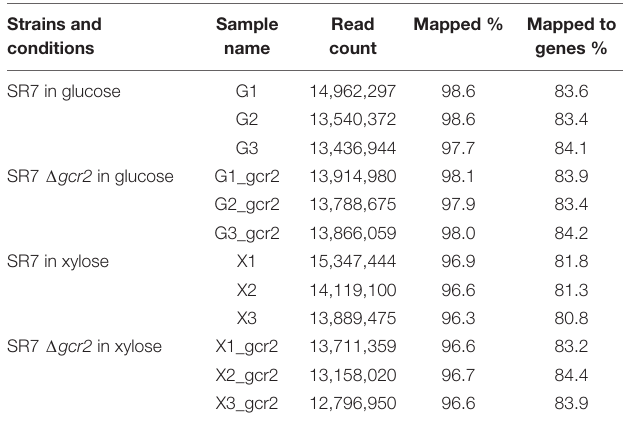
TABLE 2 | Summary of RNA-seq quality, read counts, mapping rates, and transcript